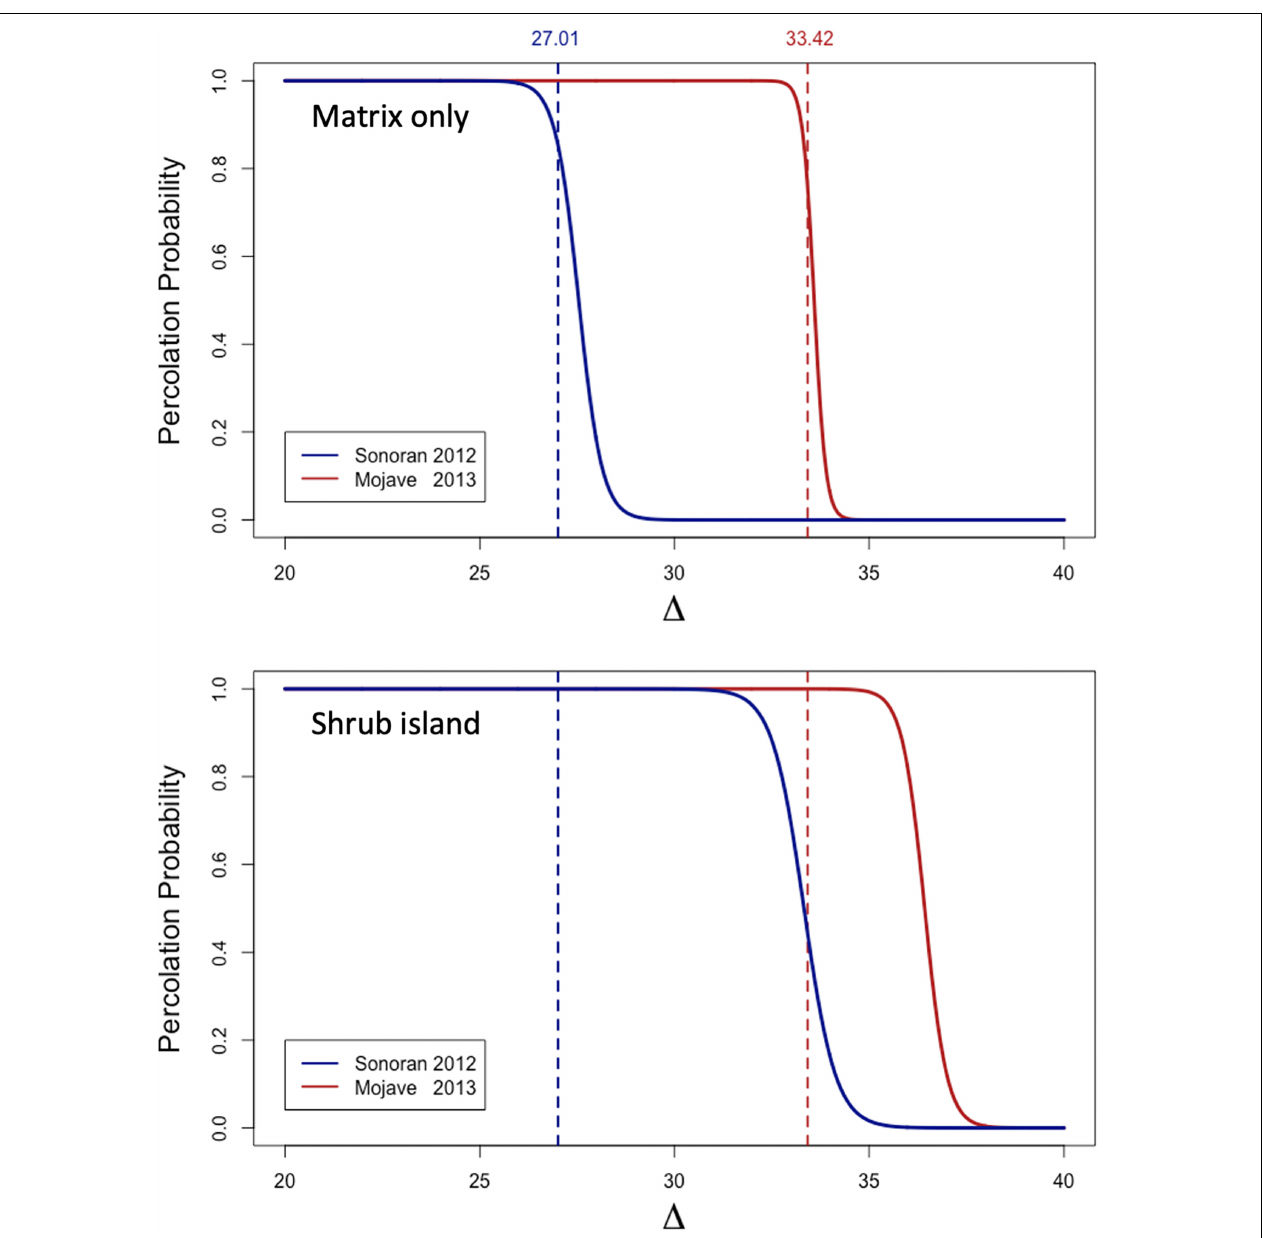
FIGURE 10 | Percolation probability as a function of biomass cutoff values ( (cid:49) ) for high precipitation conditions during best growth years in Sonoran and Mojave Desert experiments, 2012 and 2013, respectively. Vertical dashed lines correspond to the biomass value that lies at p crit as predicted from the gamma distribution for OF sites ( Table 3 ). Top panel: These are the percolation probabilities for a model containing only matrix habitat based on the OF experimental plots for Sonoran and Mojave Desert Experiments. Bottom panel : These are the percolation probabilities for a shrub island model during the same